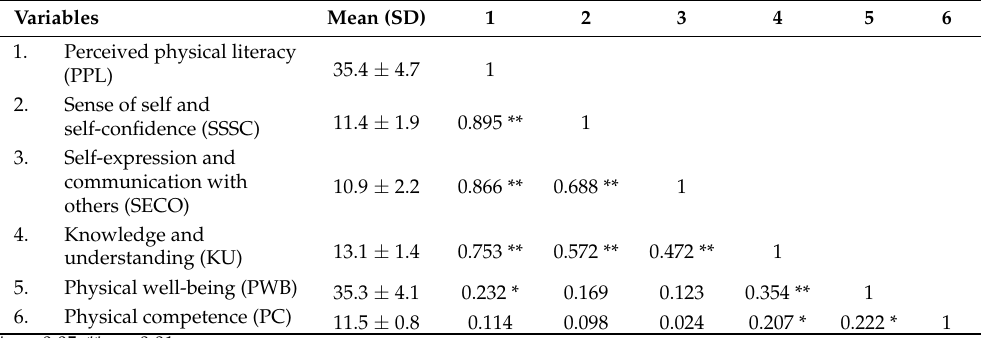
Table 3. Pearson correlation coefficients among the studied independent and dependent